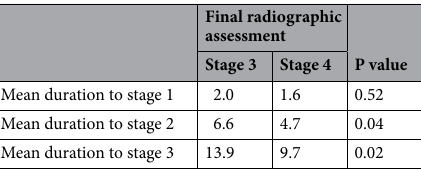
Table 2. Durations (in months) of radiographic stages at the final